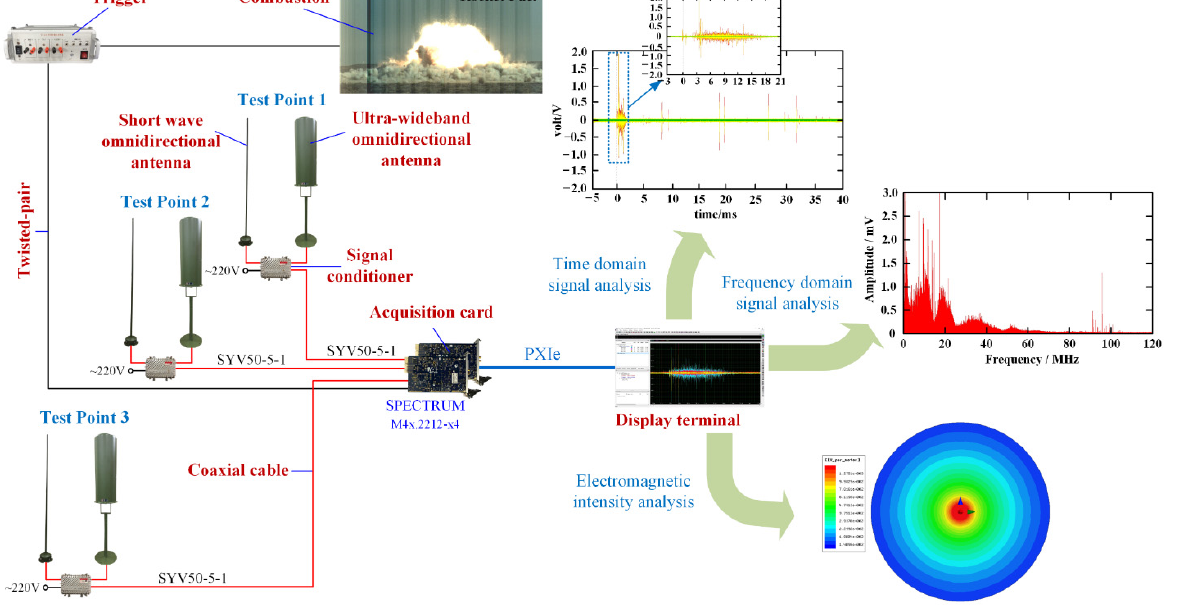
Figure 2. Electromagnetic radiation measurement and analysis process.